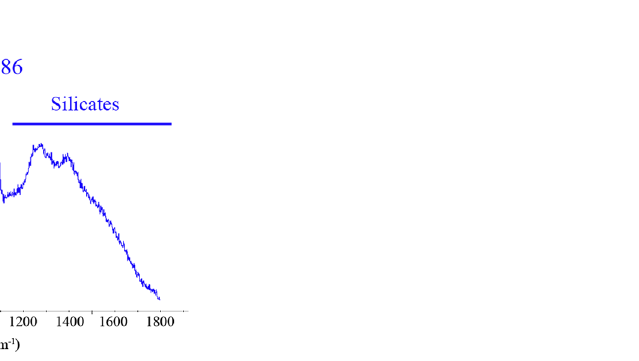
Figure 5. Raman spectra of the A4 wall of the peristyle. ( a ) Niter (715, 1050, 1342 and 1359 cm − 1 ) together with aphthitalite (452, 621, 992, 1083 and 1204 cm − 1 ). ( b ) Nitratine (1067 cm − 1 ), calcite (157, 285, 713 and 1085 cm − 1 ) and the complex nitrate signature (1053 cm − 1